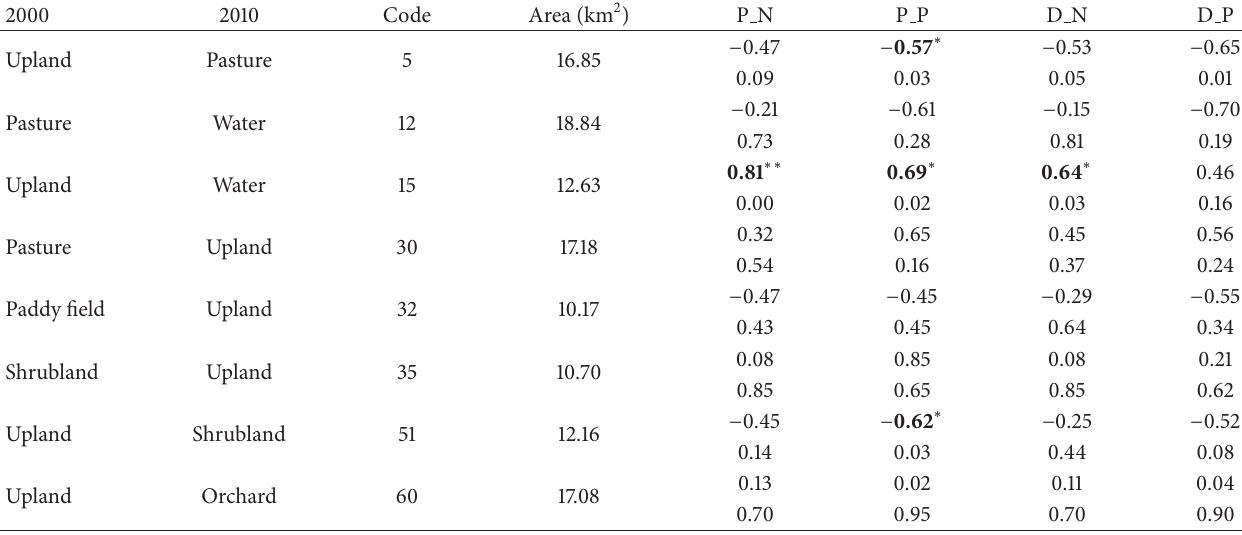
Table 6: Spearman correlation coefficients and probabilities ( 𝑃 value). Correlations between percentage of land use conversion within a subbasin and water quality variables. Bold coefficients indicate significant relationships.